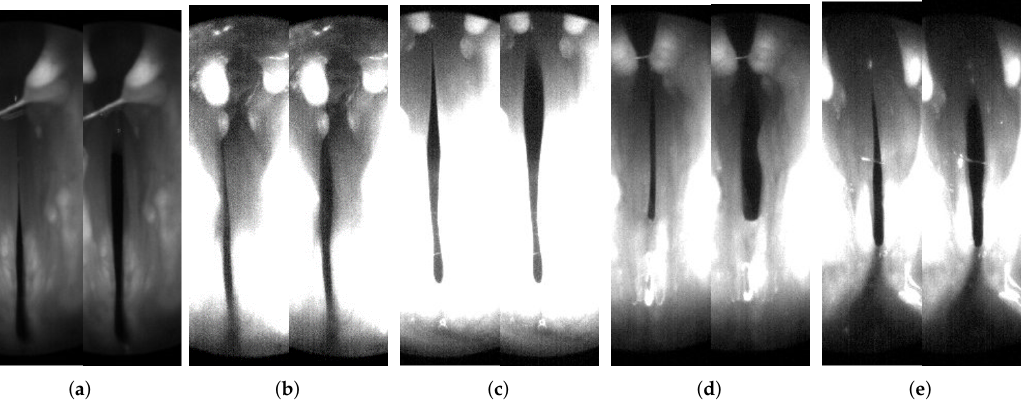
Figure 1. Images of the glottis during phonation (supraglottal view) from the high-speed camera for the five samples 1 to 5 in ( a – e ) respectively. The left image for every sample represents the vocal fold closure, and the right side represents the vocal fold